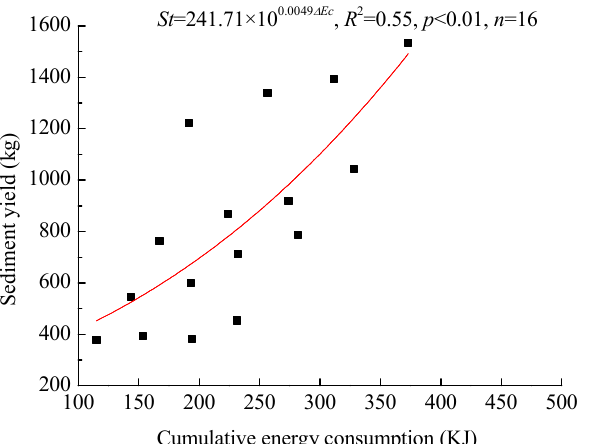
Figure 10. Relationship between the cumulative flow energy consumption and the sediment yield.